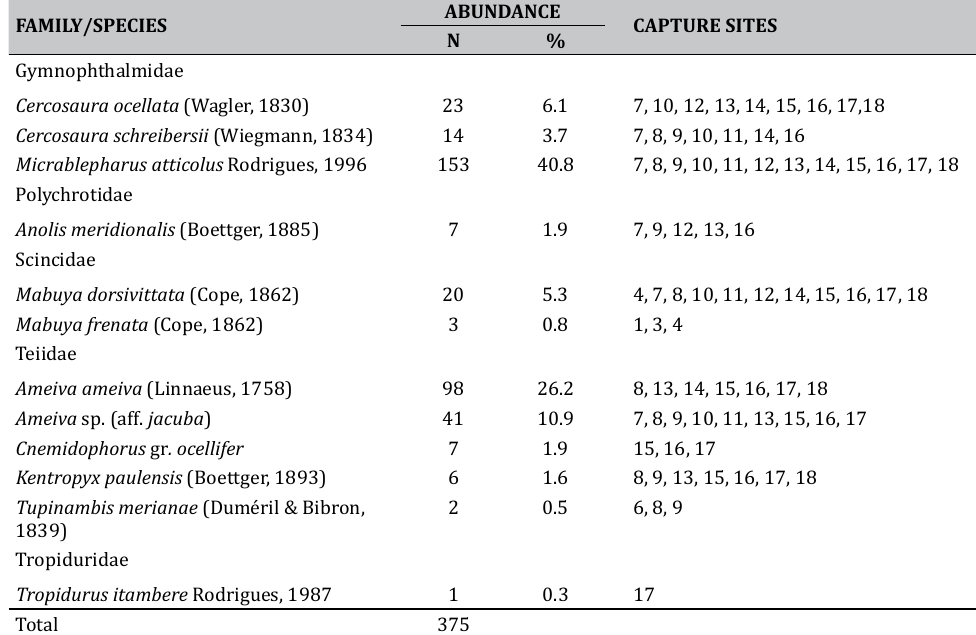
Table 1. Species composition, abundance, and capture sites (pitfall traps) of the lizard species sampled between 2008/2009, and 2011/2012 at the Estação Ecológica de Santa Bárbara, state of São Paulo, Brazil. FAMILY/SPECIES ABUNDANCE CAPTURE SITES N